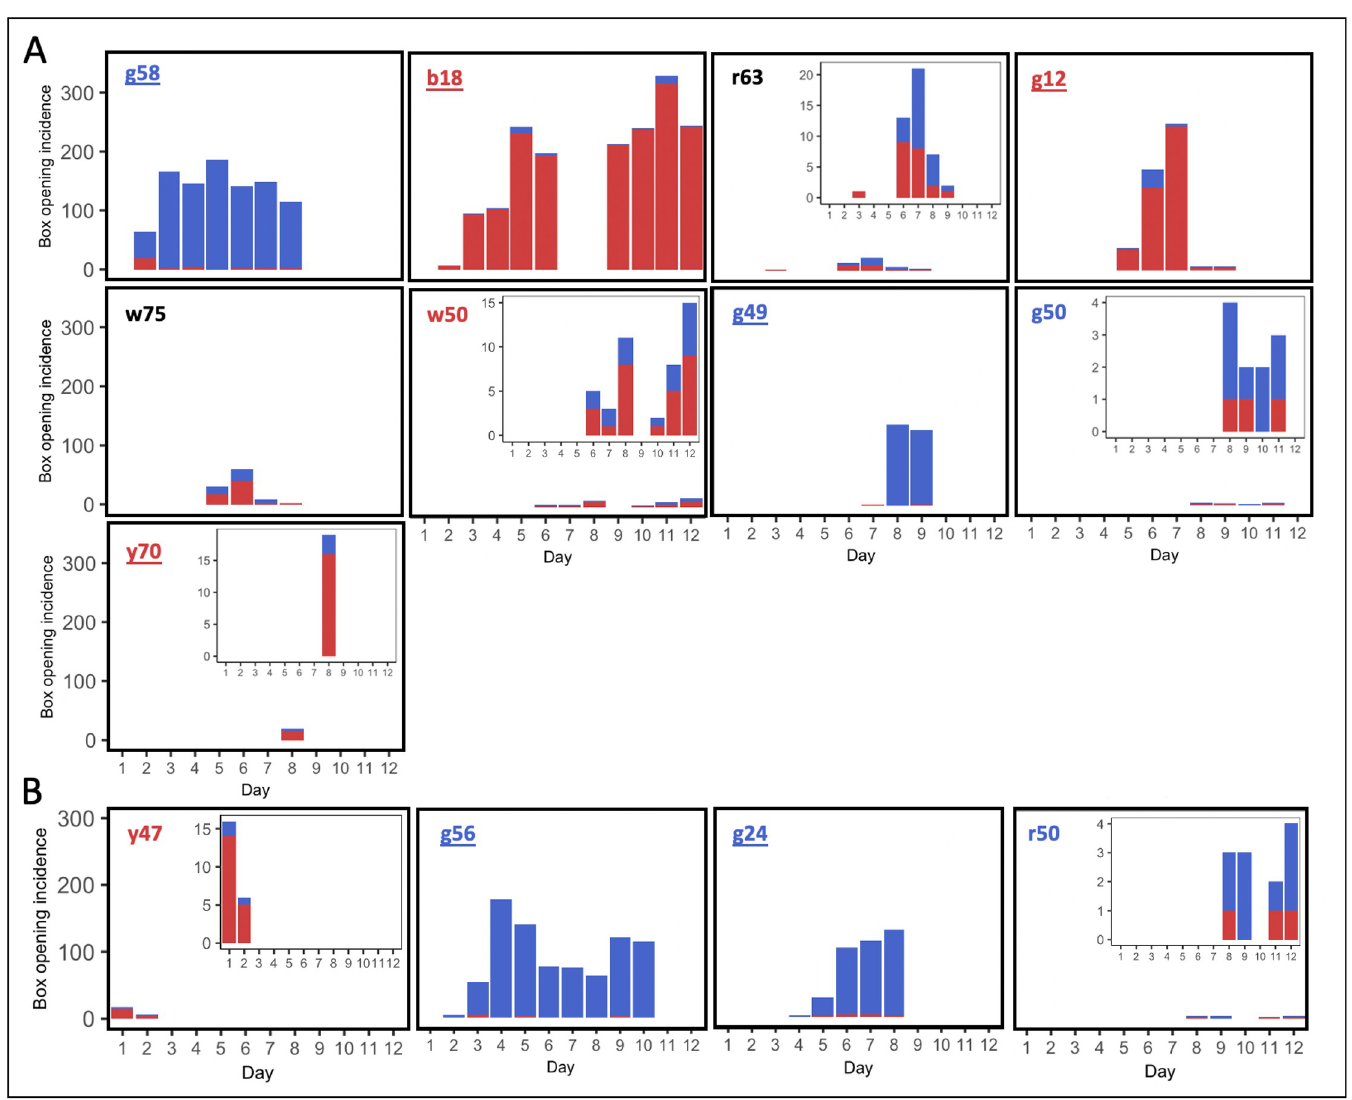
Fig 5. Box-opening incidence for individual proficient learners from (A) colony 1R2B2 and (B) 2R2B2. Overall preferences are indicated by the colour of the graph titles and strong preferences are indicated by an underline. Inset graphs show the same data at a finer scale, in cases where daily incidence is especially low and so difficult to read on the common scale. The data underlying this figure can be found in